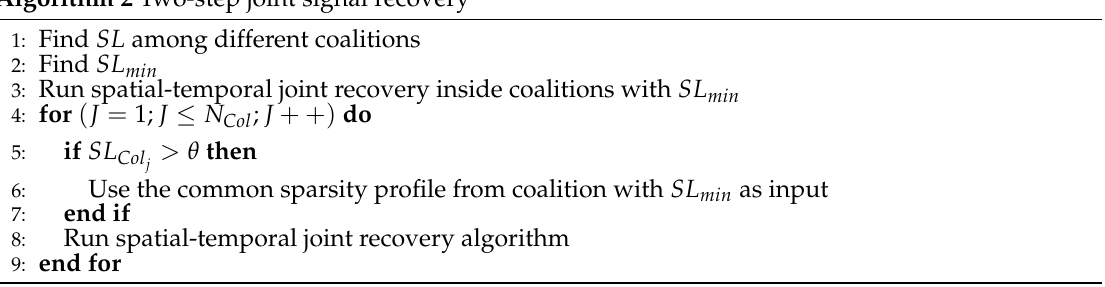
Algorithm 2 Two-step joint signal